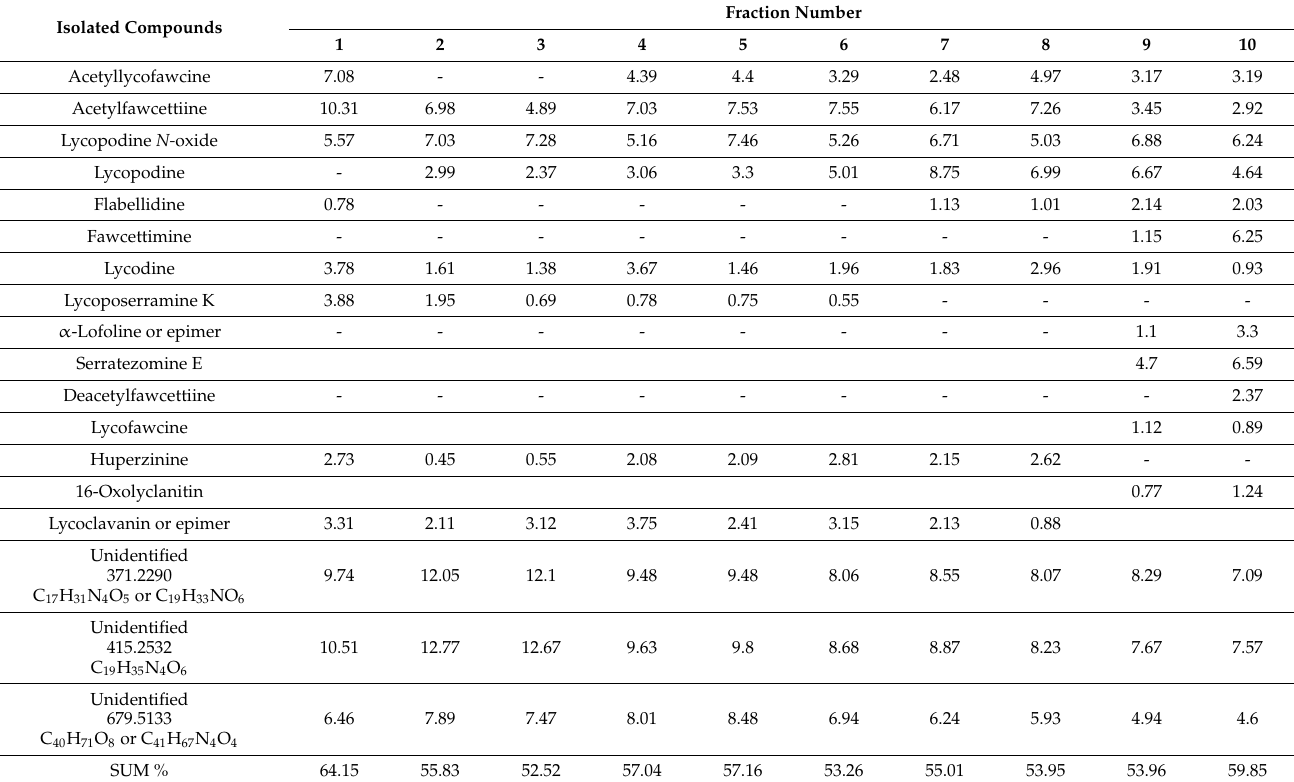
Table 8. Results of alkaloids identified via HPLC/ESI-QTOF-MS present in fractions 1–10 obtained from experiment 2 via VLC using sorbents Al 2 O 3 and silica gel in ratio 3:1 from L. clavatum